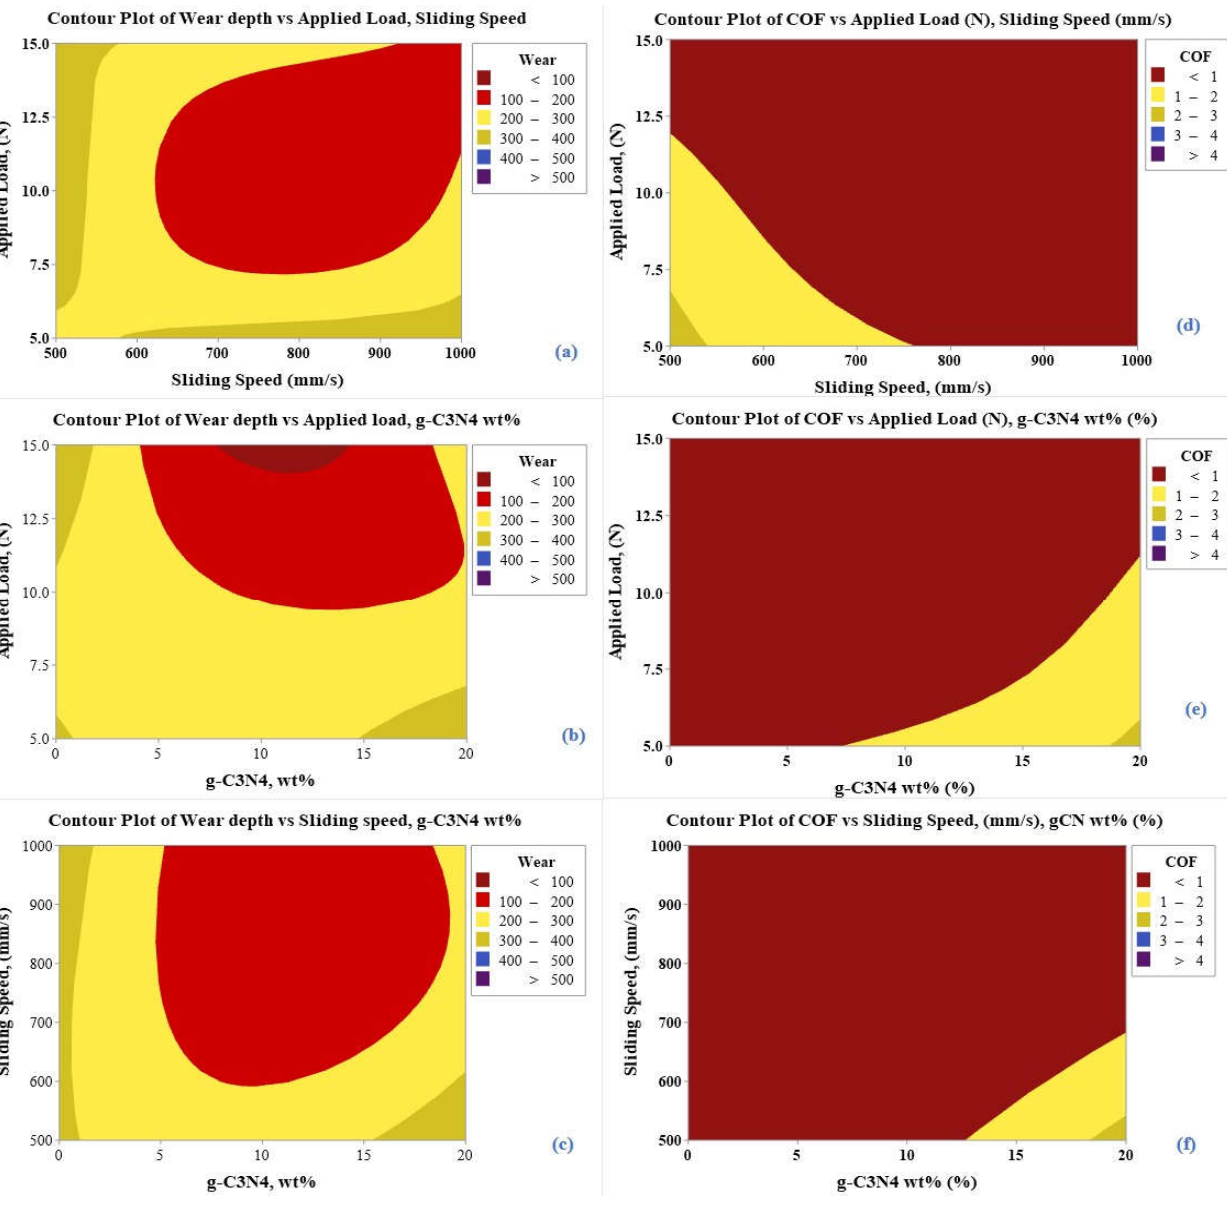
Figure 6. Contour plot for wear depth and coefficient of friction for ( a,d ) applied load vs. sliding speed; ( b,e ) applied load vs. weight percent of g-C 3 N 4 in composite; ( c,f ) applied load vs. weight percent of g-C 3 N 4 in composite.